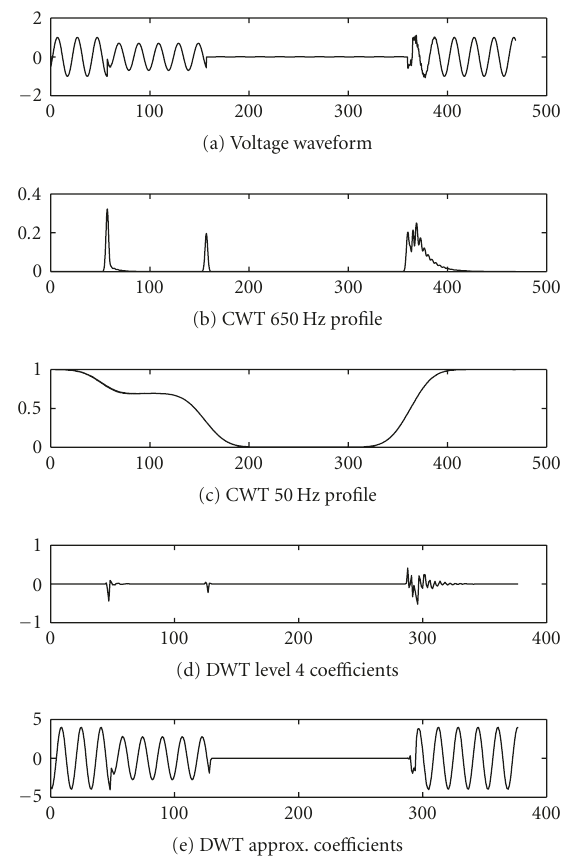
Figure 3: Characterization of a short-duration voltage dip.